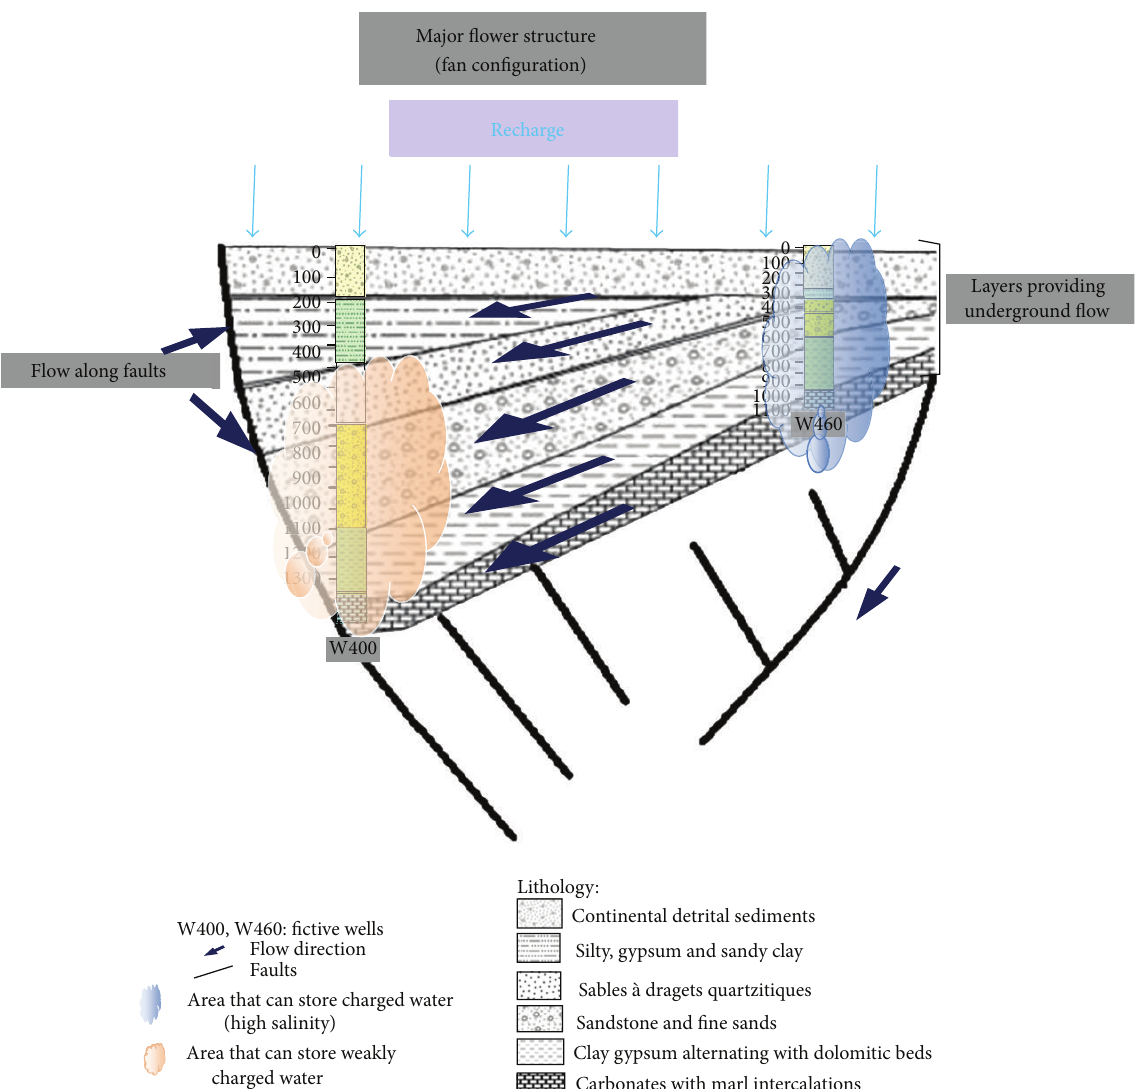
Figure 12: Hydrogeological sketch of Ouled Asker basin with W400 and W460 fictive